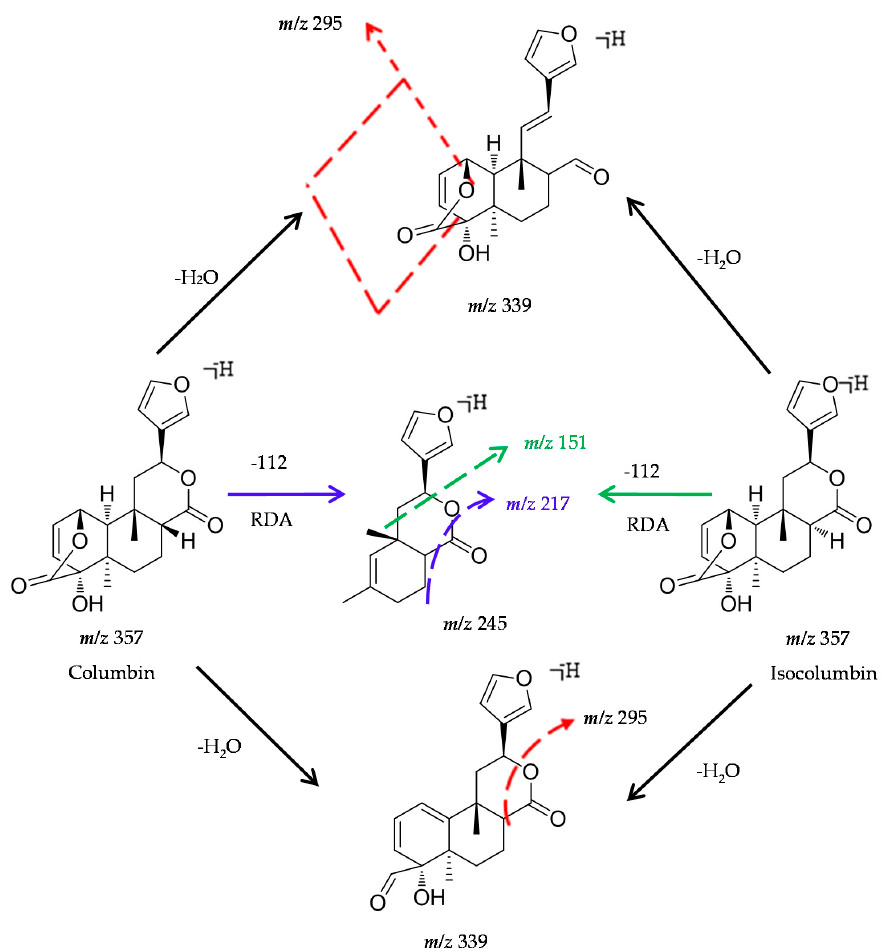
Figure 1. Proposed MS/MS mechanistic pathways for columbin and isocolumbin.